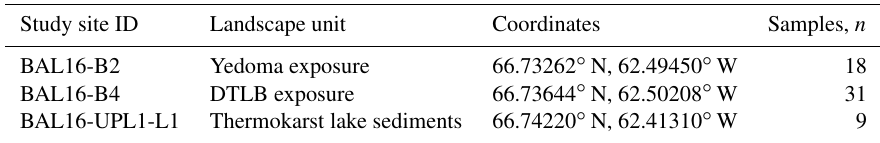
Figure 1. (a) Overview map of Siberia and Alaska with indicated study region (red square). (b) Close-up of Kotzebue Sound with indicated study region (red square). (c) Study sites on Baldwin Peninsula presented in this study (purple filled dots) and additional sites used in the organic carbon pool calculations (white dots); false color image with short-wave infrared, near-infrared and deep-blue bands (7-5-1); Source for background map in (a) and (b) : World Ocean Base (ESRI); satellite image map (c) : Landsat 8 image from 13 October 2016, USGS/NASA. Table 1. Overview of study sites of yedoma exposure, drained thermokarst lake basin (DTLB) exposure and thermokarst lake sediments. BAL: Baldwin Peninsula, 16: expedition in 2016, B: bluff sampling, UPL: upland sampling, L: lake